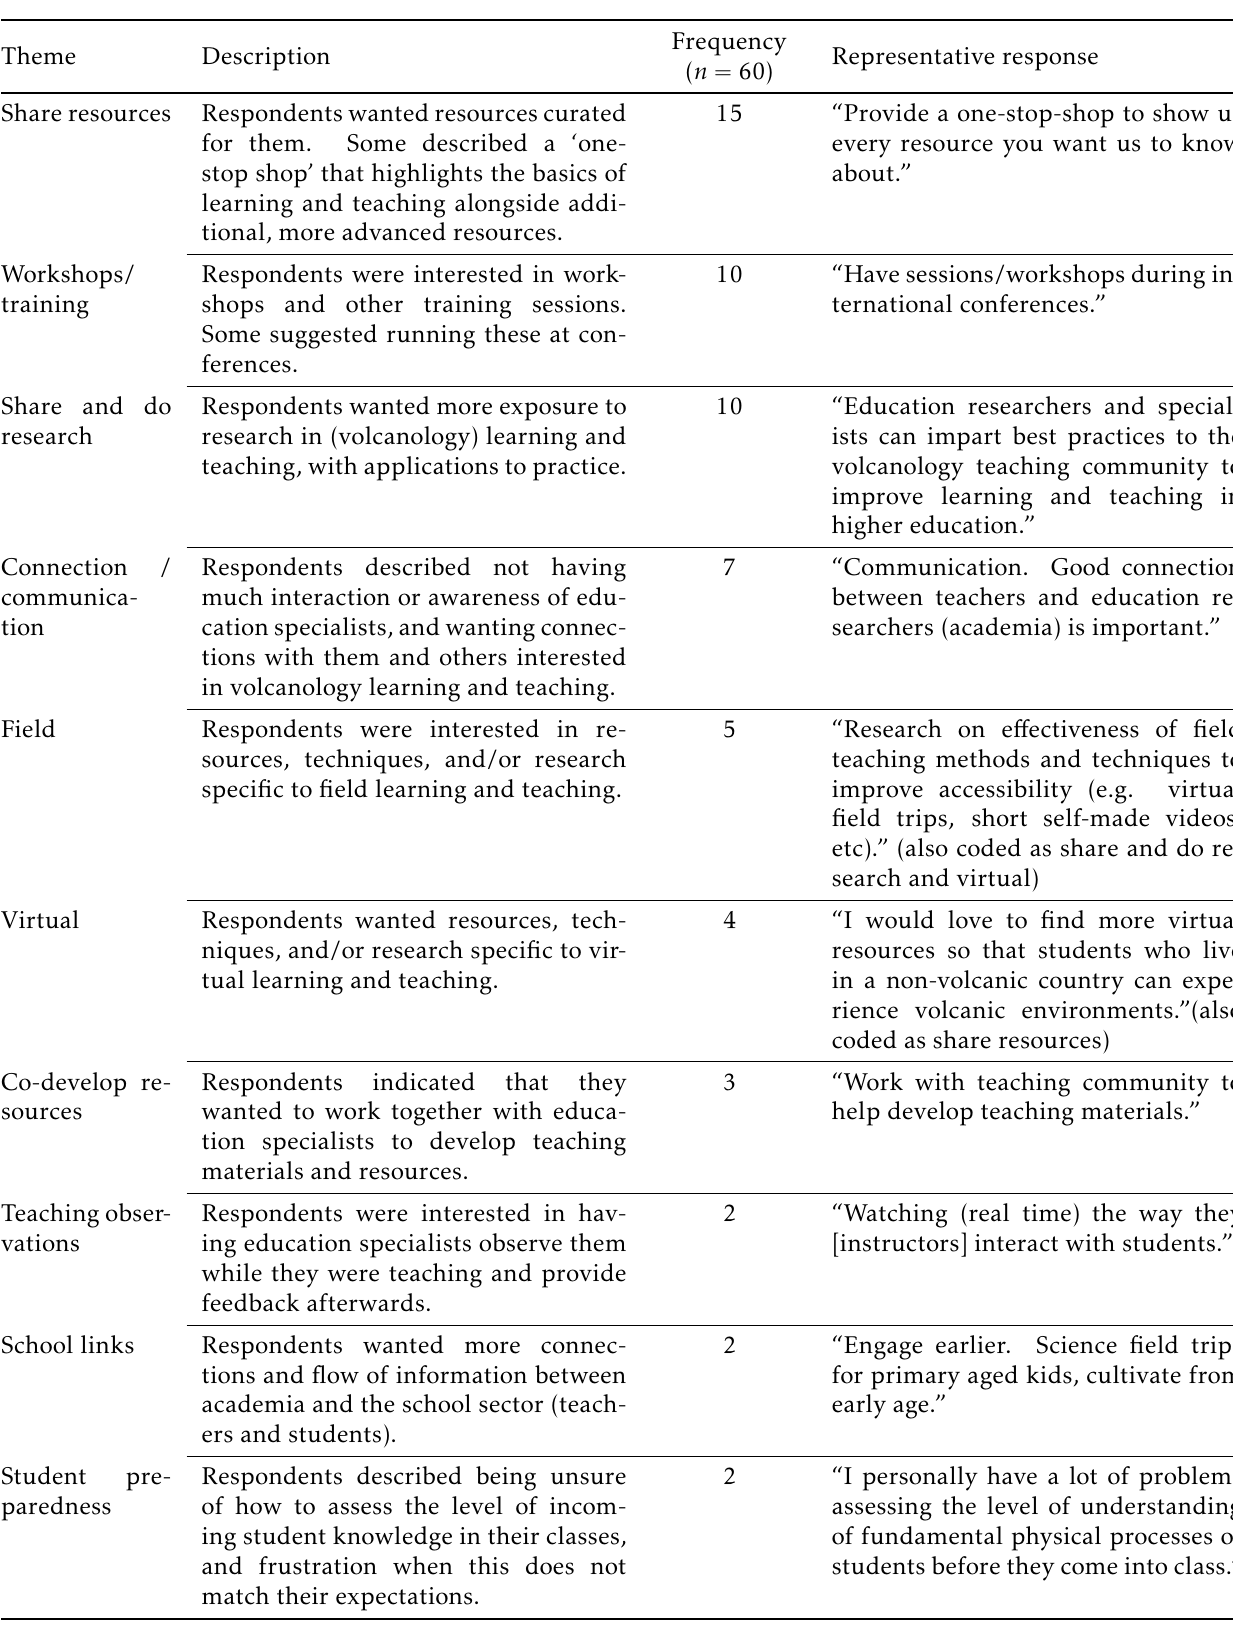
Table 2: Representative responses for themes identified in the open-ended responses to how education specialists might help improve volcanology learning and teaching. There were 39 unique responses to this question and 60 total occurrences of